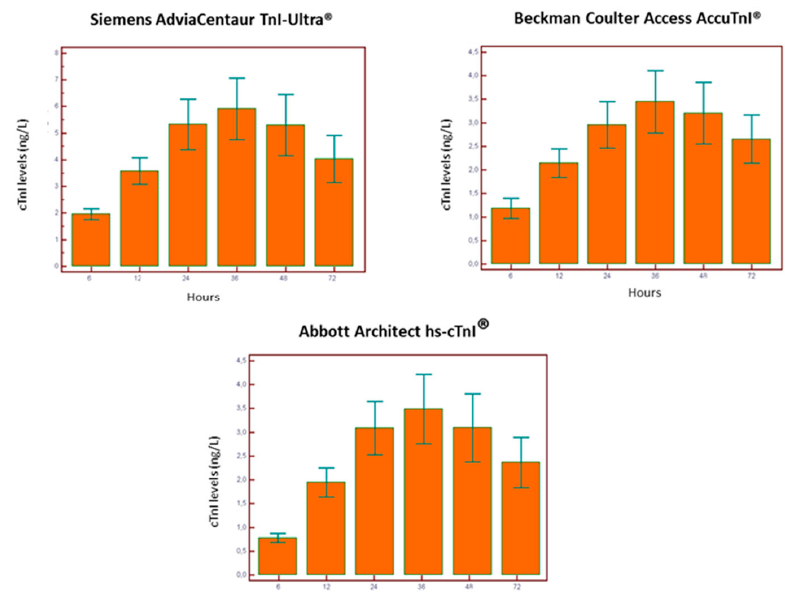
Figure 3. Time-related cTnI cutoff values in patients who underwent Figure 3. Time ‐ related cTnI cutoff values in patients who underwent CABG.